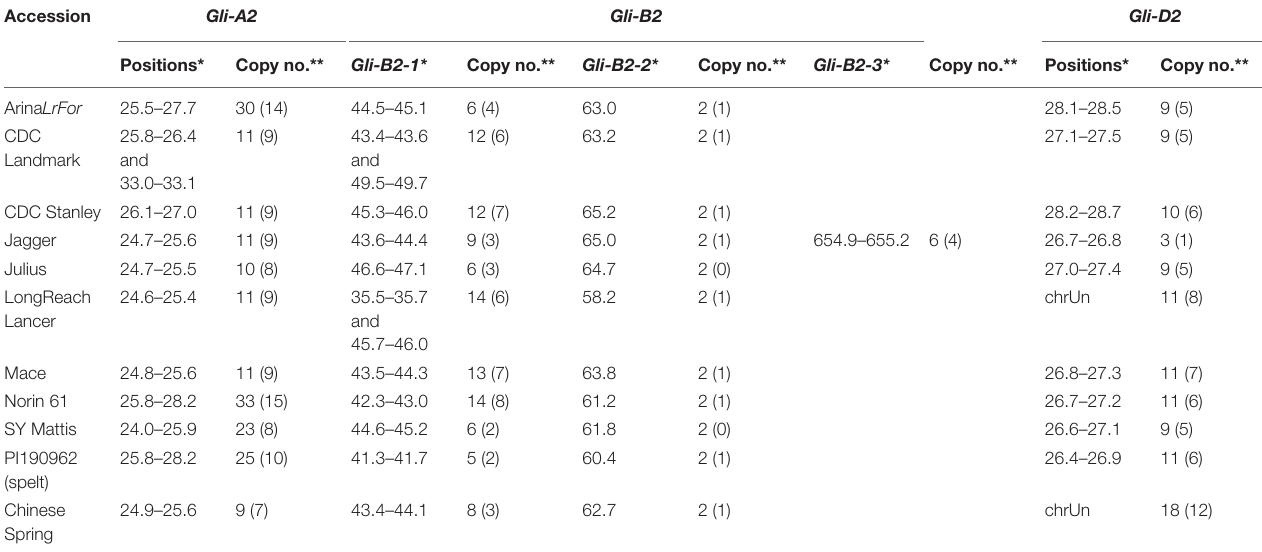
TABLE 1 | Genomic positions of Gli-2 loci in 11 wheat